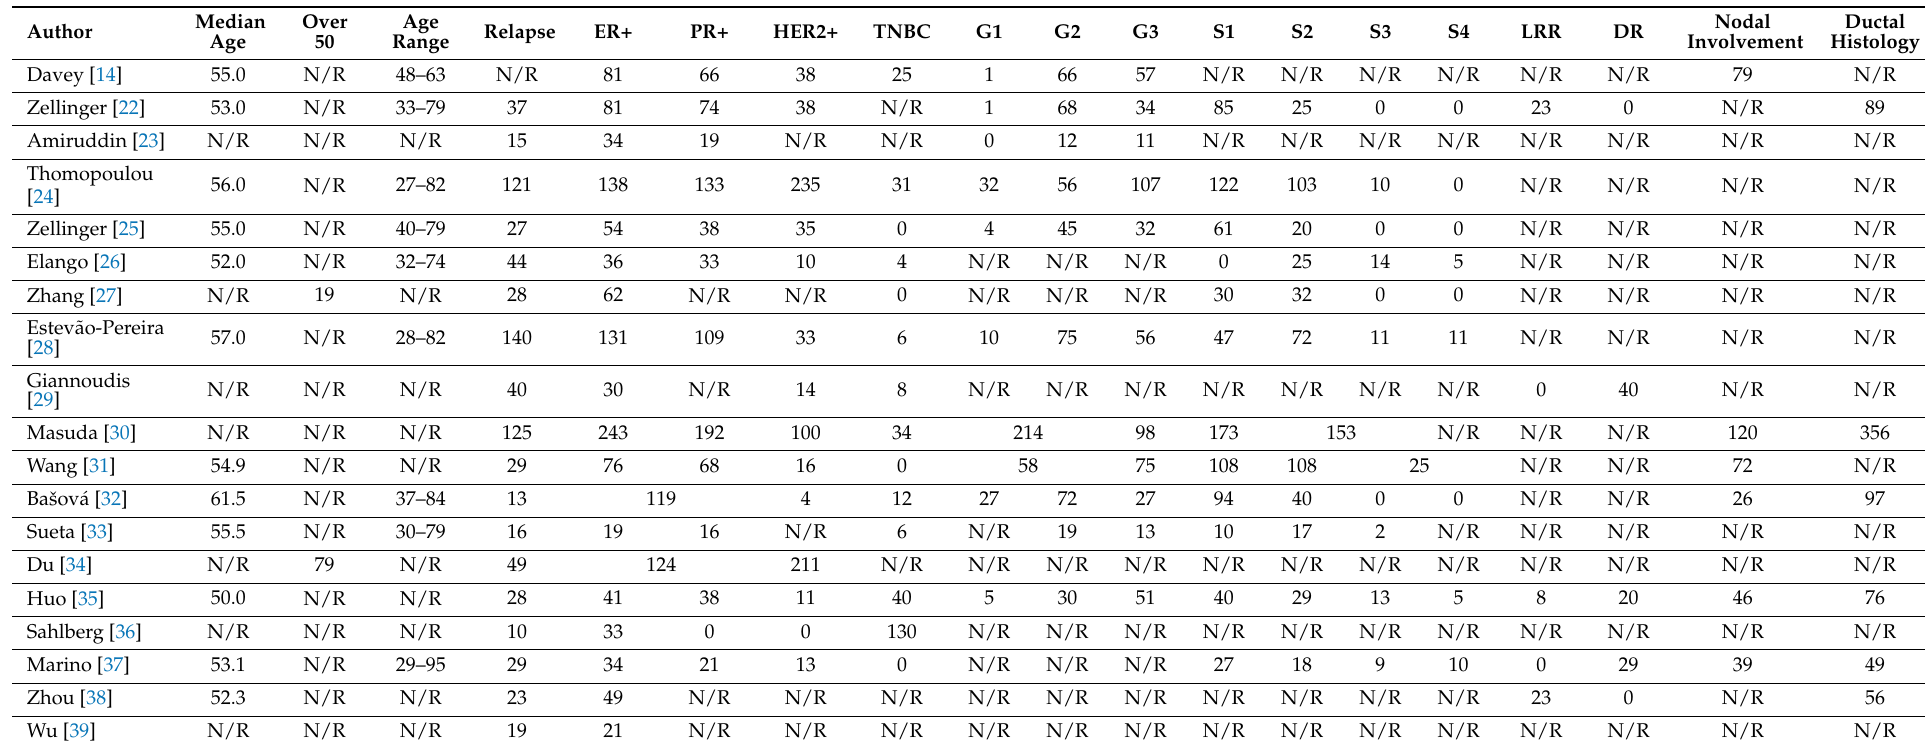
Table 2. Basic clinicopathological parameters from the included